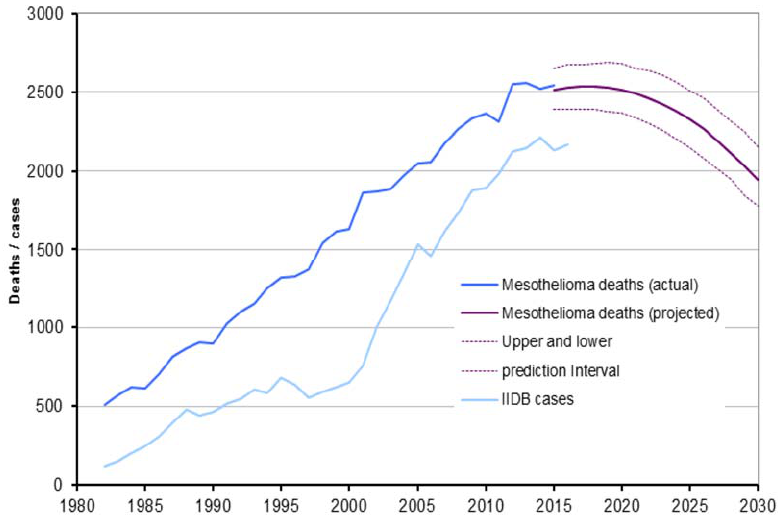
Figure 3. Mesothelioma annual deaths, Industrial Injuries Disablement Benefit (IIDB) cases and projected future deaths to 2030 in GB, Health and Safety Executive/UK 2016.